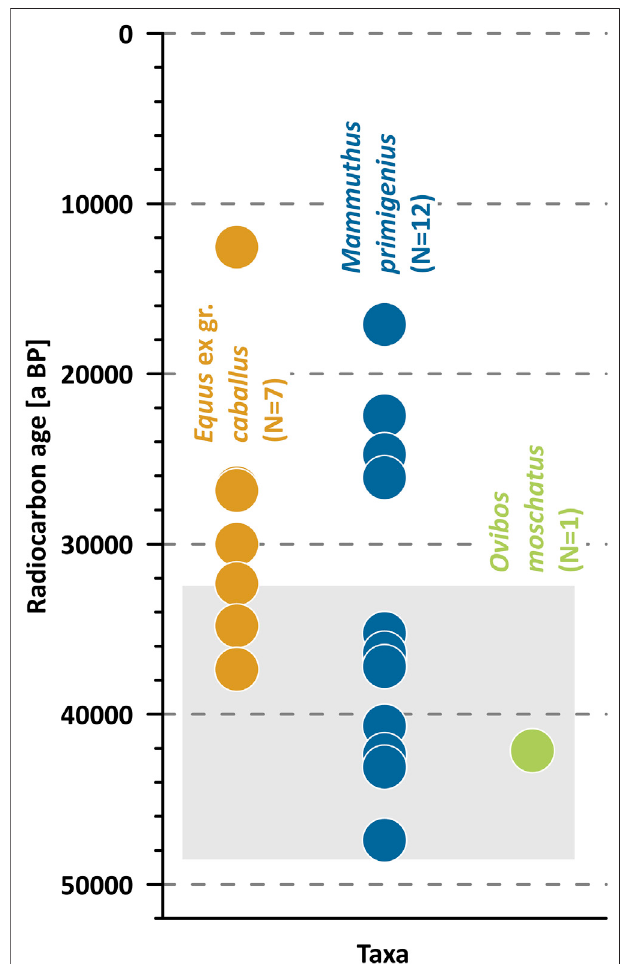
FIGURE 8 | Distribution of radiocarbon ages of mammal bones differentiated by taxa from the Kondrat ’ eva Yedoma exposure including data from Nikolskiy et al., 2011 (N = 6), Rompler et al., 2006 (N = 1), and this study (N = 13). Only fi nite dates are given as uncalibrated ages. The gray rectanglehighlightedtheagerangeofKondrat ’ evaYedomaIceComplexhost deposits, which was radiocarbon-dated from 48.5 to 32.2 ka a BP (Schirrmeister et al.,